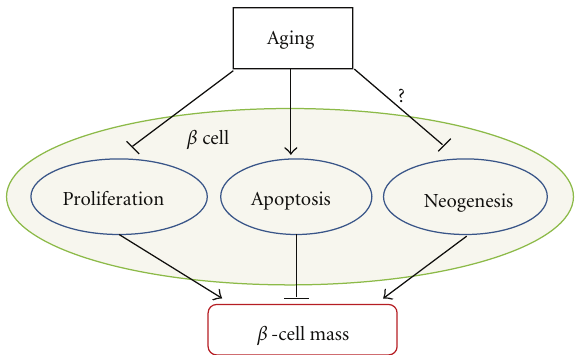
Figure 2: Factors that control β -cell mass in aging. β cell pro- liferation, apoptosis, and islet neogenesis are three major factors that control β -cell mass. Through di ff erentially regulation of these factors, aging modulates β -cell mass, and subsequently insulin